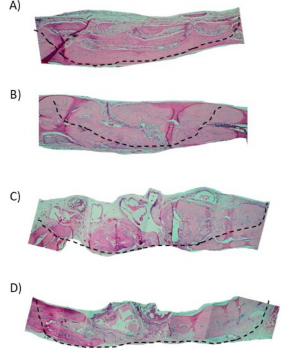
Figure 5. Histological images after 30 days (40 × magnification), the line indicates the region of the bone defect (100 × magnification). ( A ) Blood clot group (G1); ( B ) autogenous bone group (G2); ( C ) xenogenous bone group (G3); ( D ) xenogenous bone associated with the micro graft group